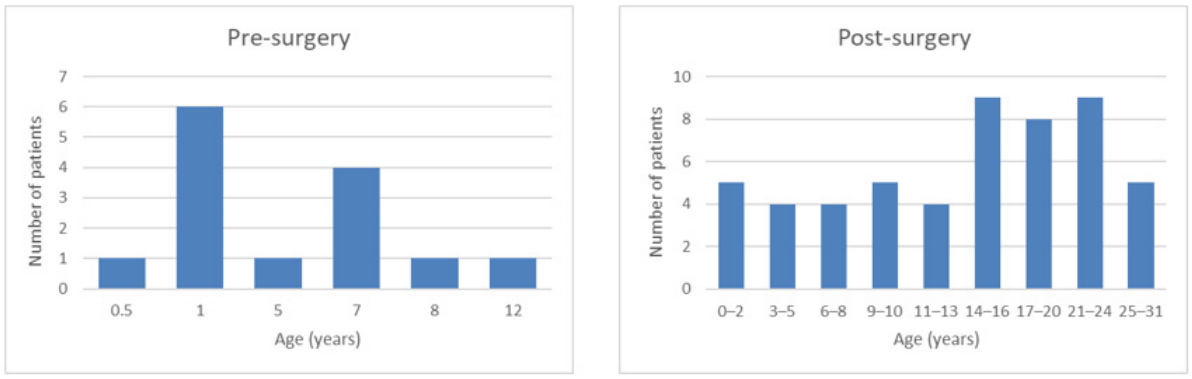
Figure 1. Age distribution of the study sample including 14 patients in the Pre-surgery group ( left ) and 53 patients in the Post-surgery group ( right ).